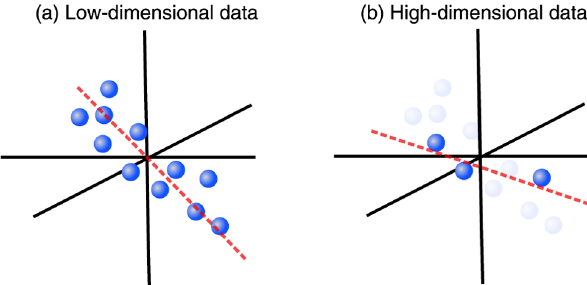
FIG. 1. A cartoon view of low-dimensional (a) versus high- dimensional (b) data. In the latter scenario, a finite measurement density, or ratio between data points and dimensions, leads to errors in